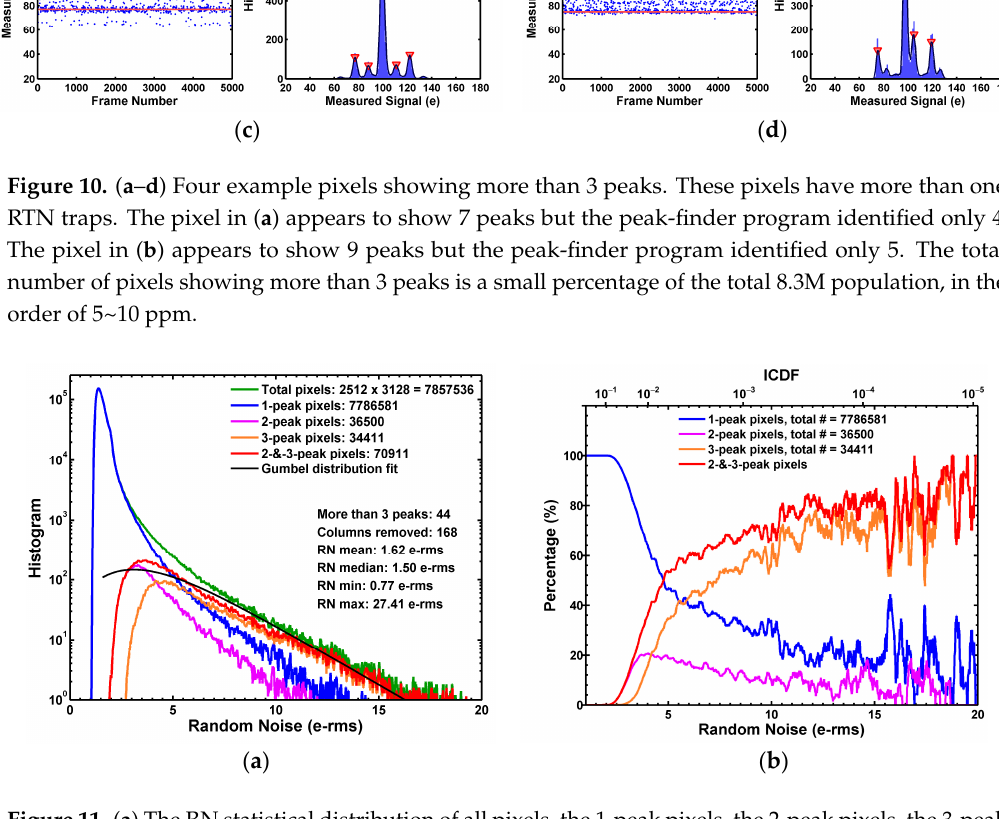
Figure 11. ( a ) The RN statistical distribution of all pixels, the 1-peak pixels, the 2-peak pixels, the 3-peak pixels, and the sum of the 2-peak and 3-peak pixels; ( b ) The 1-peak pixels, 2-peak pixels, 3-peak pixels, and the 2-or-3-peak pixels as the percentage of the total pixels. The key observation is that the 2-or-3-peak (single-trap) pixels are dominant in the high noise region with RN > 10 e − rms.